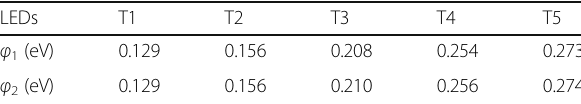
Table 1 Valence band barrier height for each PNP-AlGaN junction of LEDs T1, T2, T3, T4, and